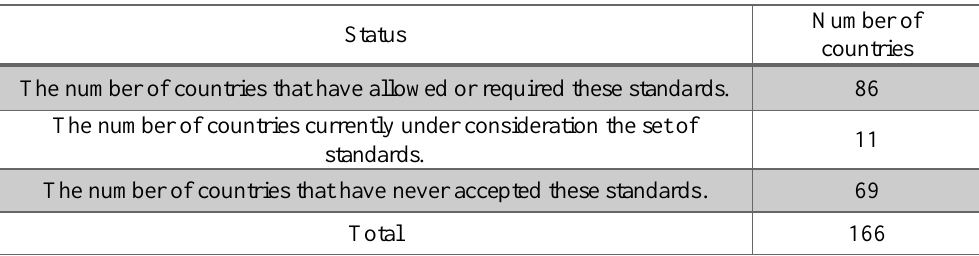
Number of countries 11